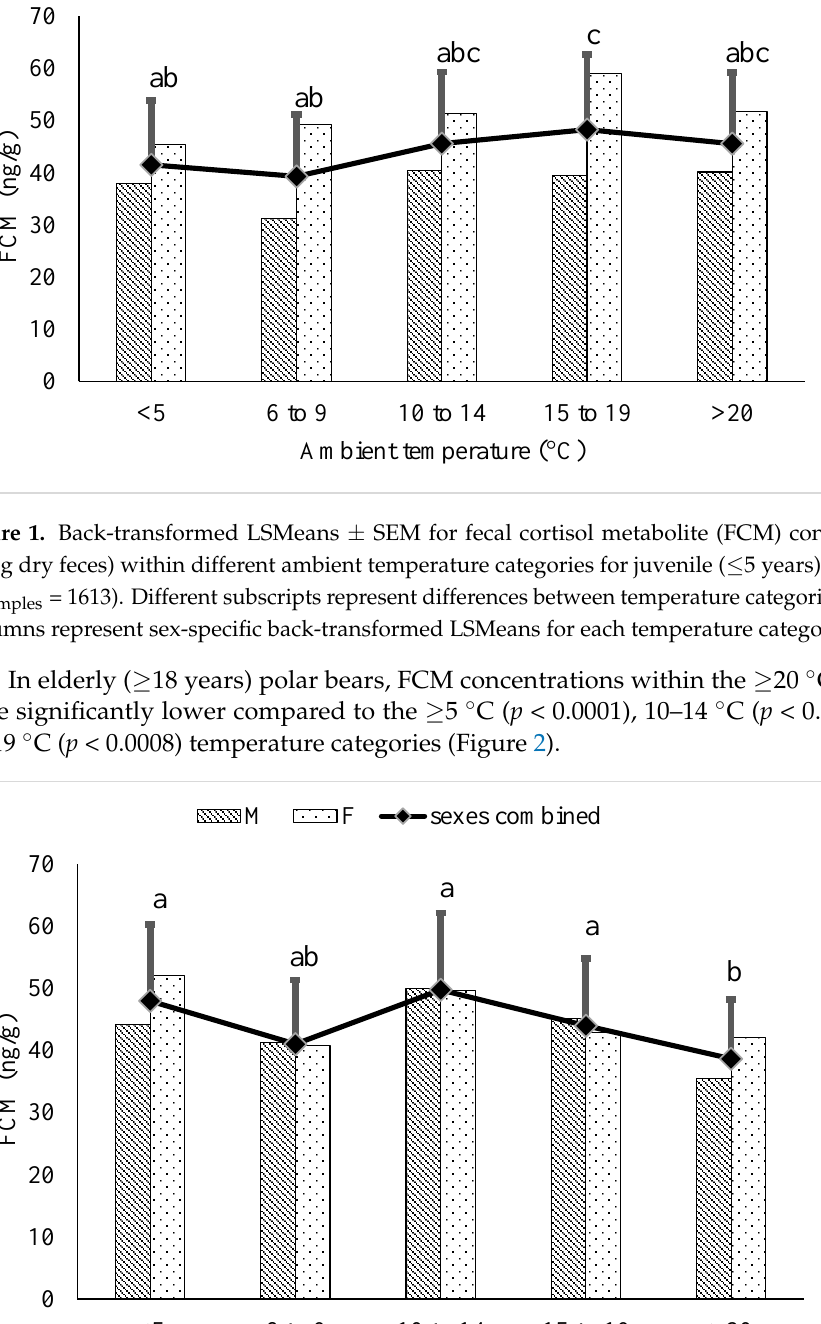
( p = 0.0452) temperature categories (Figure 1). The FCM levels in the ≥ 20 ◦ C category were not different from the other temperature categories ( p > 0.05).